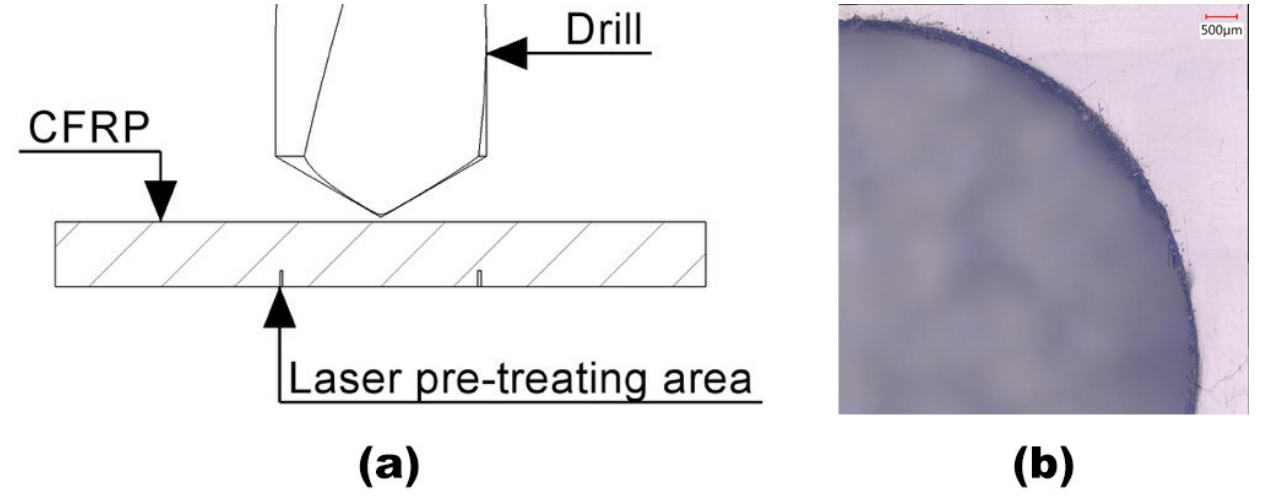
Figure 18. ( a ) Schematic diagram of combined laser pretreatment and mechanical hole drilling process; ( b ) Hole exit showing no fibre delamination.